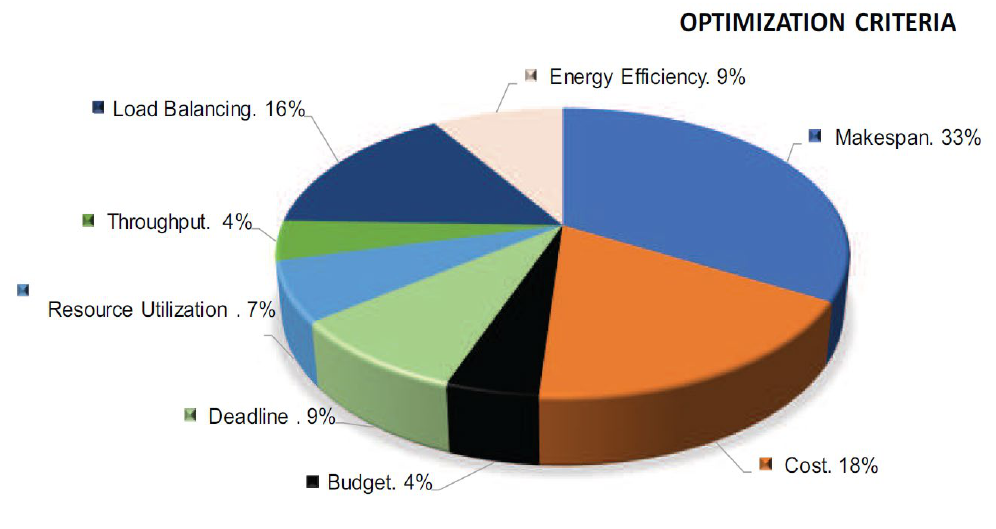
Figure 5. The Frequency of optimization criteria considered by meta-heuristic techniques These factors influence providers' outcome and